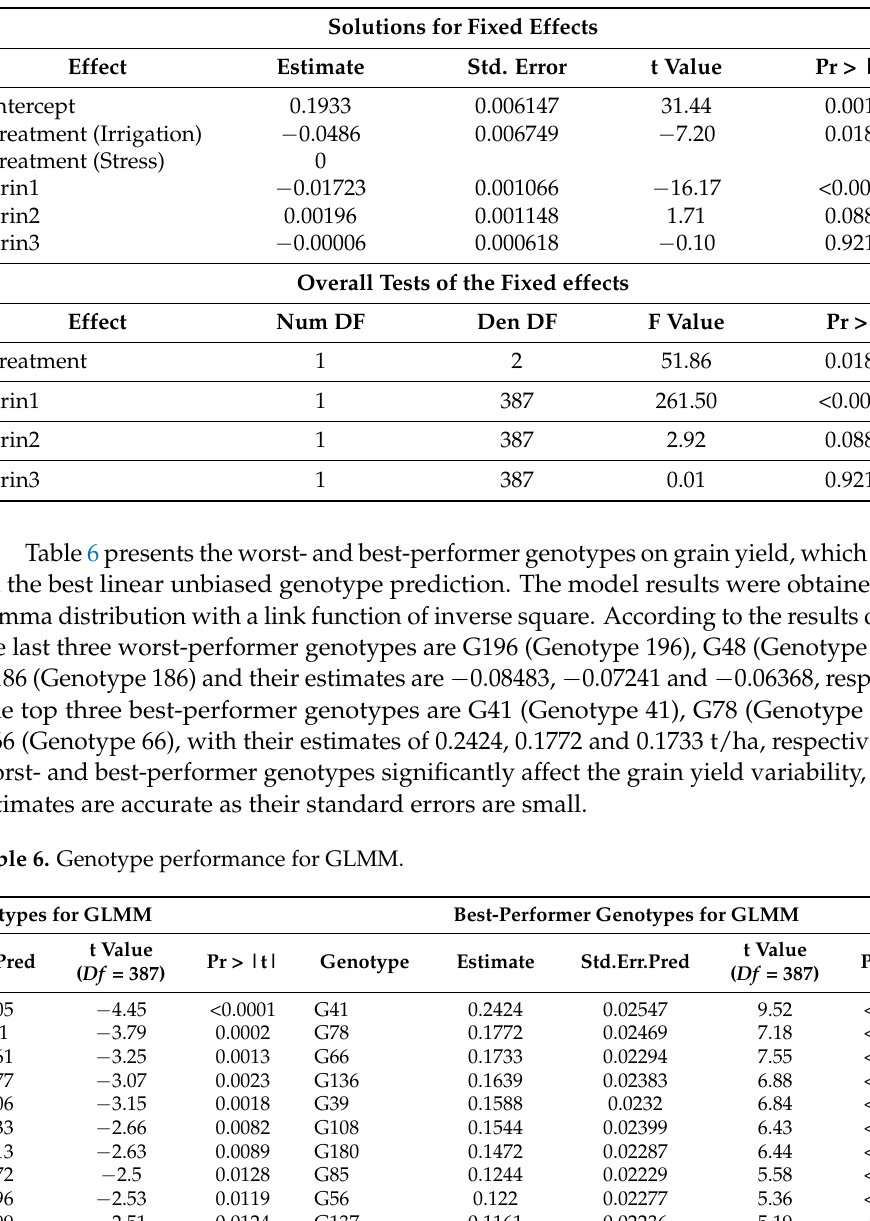
Table 5. The estimates and tests of the fixed effects of the GLMM.